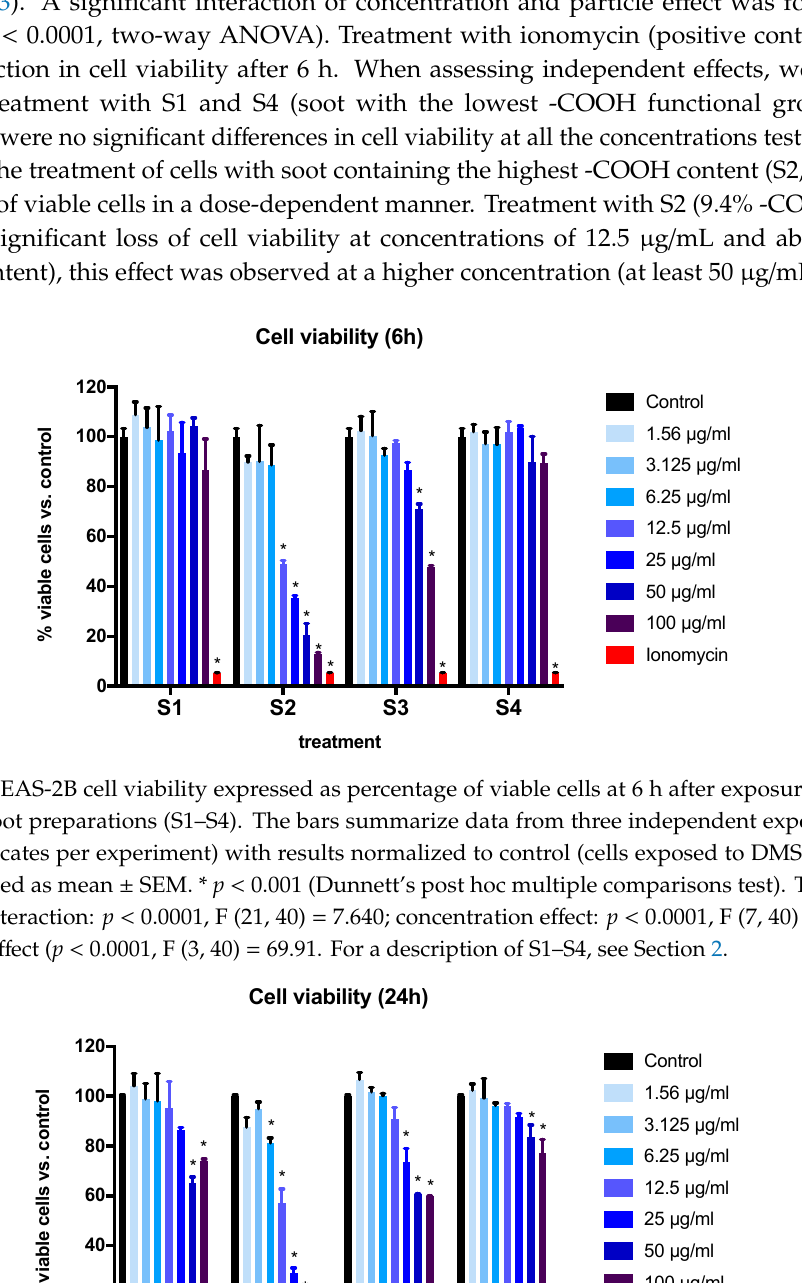
Table 2. Oxygen group percentages for samples S1–S4.